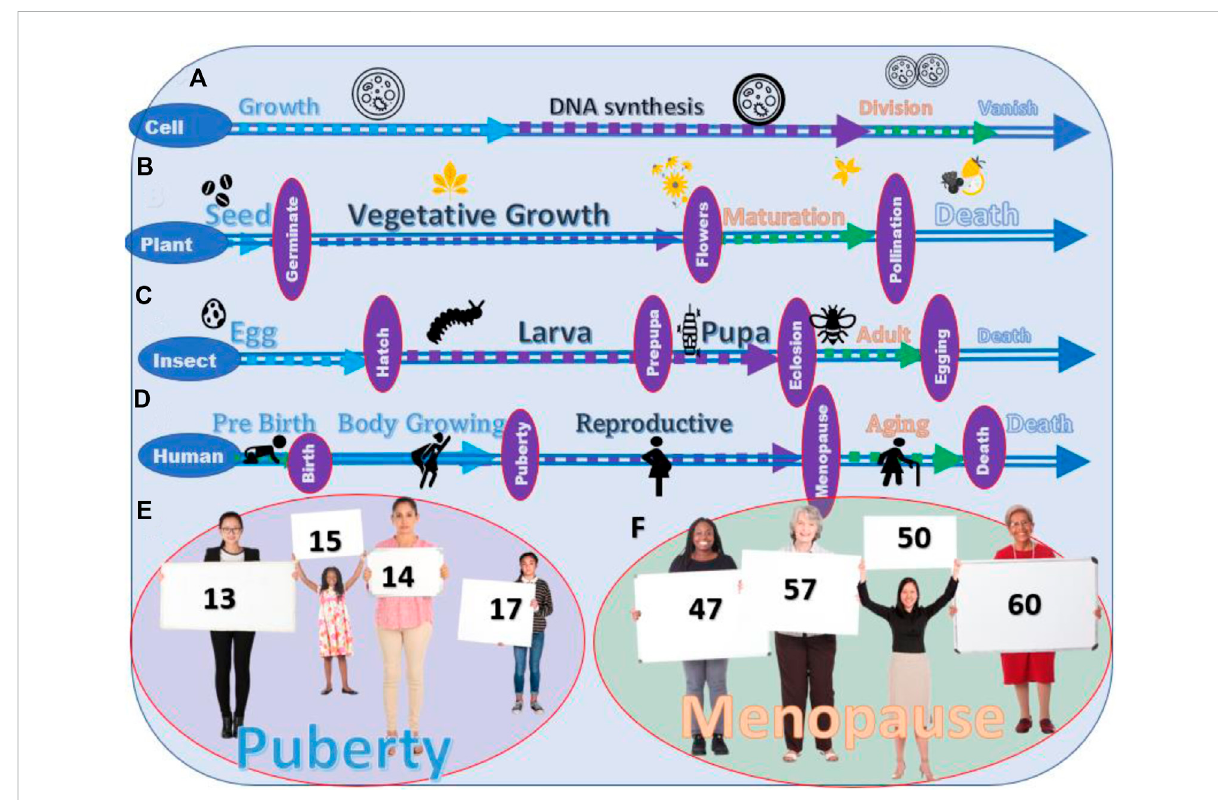
FIGURE 1 Lifestagesofdifferentlivingcreatures. (A) Thestagesofthelifecycleofacell. (B) Stagesofthelifecycleofcropsandvegetables. (C) Fourstages ofthelifecycleofmostinsects. (D) Stagesofthelifecycleofhumans. (E) Variationintheageofpubertyamongyoung people. (F) Variationintheage of menopause among the